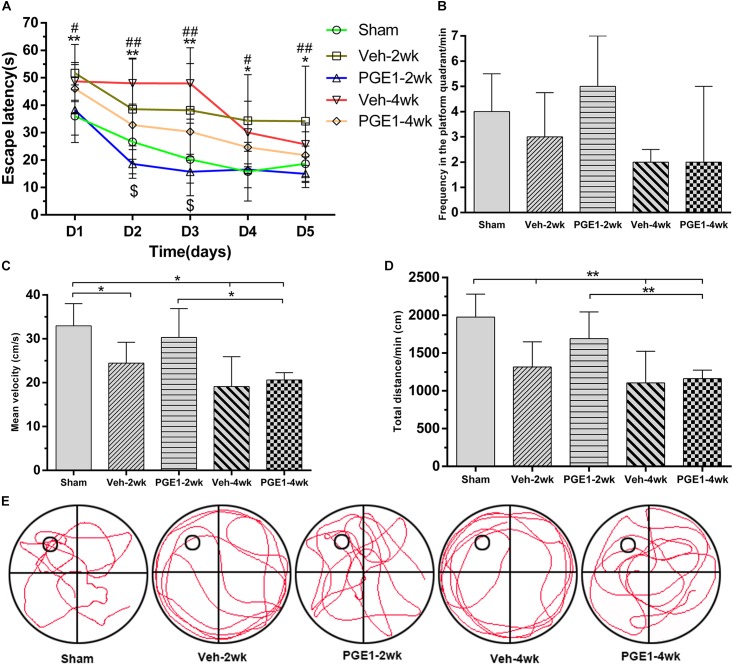
PGE1 alleviates cognitive impairment as measured by Morris water maze (MWM) test. (A) Escape latency changes in the different groups from days 1 to 5 of MWM test. Data are presented as mean ± SD; n = 10, 8, 10, 9, 9, respectively. (∗∗p < 0.01, ∗p < 0.05, sham group vs. Veh-2wk or Veh-4wk groups; ##p < 0.01, #p < 0.05, PGE1-2wk group vs. Veh-2wk group; $p < 0.05, PGE1-4wk group vs. Veh-4wk group). (B) Changes between different groups in the frequency of time in the platform quadrant in 1 min. Data are presented as median ± interquartile range; n = 10, 8, 10, 9, 9, respectively. (C) Quantitative analysis of the mean velocity in 1 min at day 6 of MWM test between the different groups. Data are presented as mean ± SD; n = 10, 8, 10, 9, 9, respectively. (D) Quantitative analysis of the total distance in 1 min between the different groups. Data are presented as mean ± SD; n = 10, 8, 10, 9, 9, respectively. (E) Swimming path of rats in different groups at day 6 of MWM test. The small empty circle represents the platform in one quadrant of the swimming pool (the large circle). Rats of the Veh-2wk and Veh-4wk groups were mainly swimming along the side wall, whereas the rats of the sham, PGE1-2wk and PGE1-4wk groups were searching for the platform purposefully.